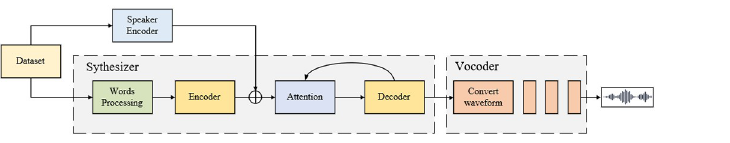
Fig 1. Overall structural framework.